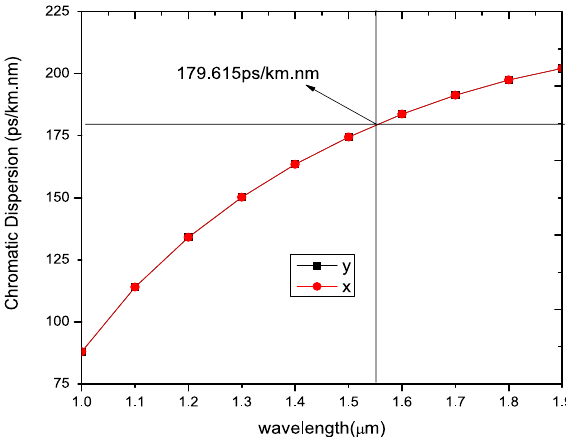
Fig. 8 Chromatic dispersion as a function of wavelength, Λ